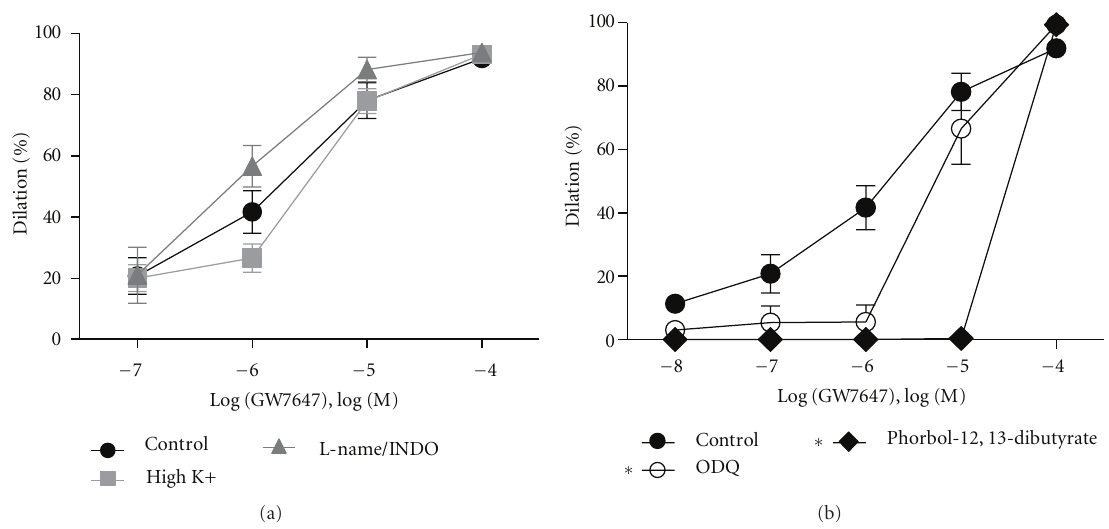
Figure 5: Exploration of the mechanism of PPAR α agonist-mediated dilation in MCAs. (a) 10 − 5 M L-name and indomethacin pretreatment did not alter dilation to GW7647 in PE-preconstricted MCAs ( n = 4). Likewise, in MCAs pretreated with high K + , dilation to GW7647 was again unaltered ( n = 4). (b) In MCAs, pretreatment with phorbol 12,13-dibutyrate, as well as with 10 − 5 M ODQ ( n = 5) impaired the dilatory response of GW7647 thereby implicating a role for PKC and sGC in the response ( n = 3). Data are means ± SEM. ∗ Indicates P ≤